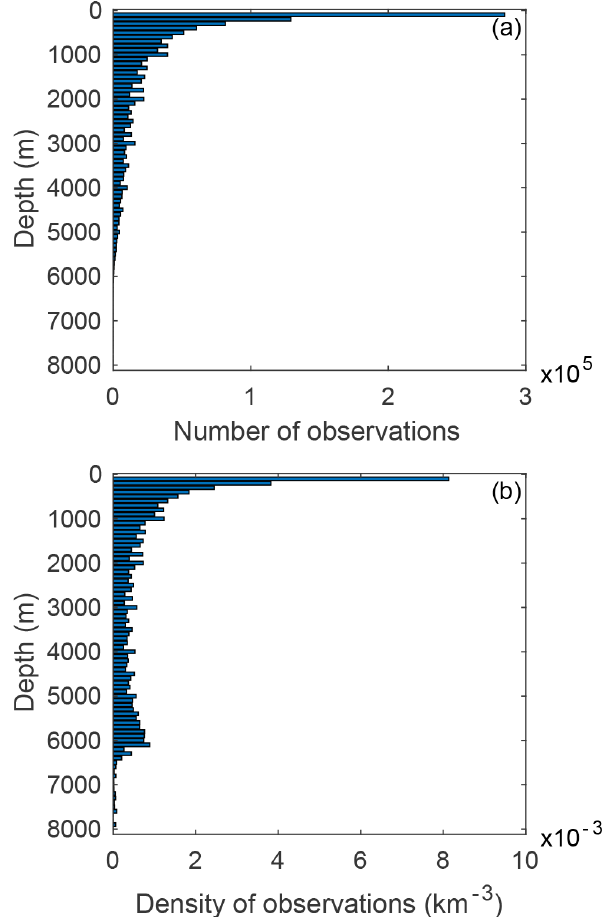
Figure 11. Number (a) and density (b) of observations in 100m depth layers. The latter was calculated by dividing the number of observations in each layer by its global volume calculated from ETOPO2 (National Geophysical Data Center, 2006). For example, in the layer between 0 and 100m there are on average approxi- mately 0.008 observations per cubic kilometer. One observation is one water sampling point and has data for several